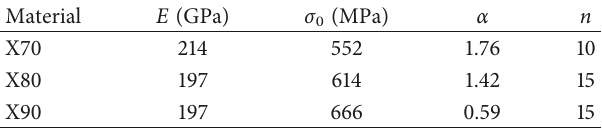
100, a / t 0.2, and θ / π 0.04: (a) X70; (cid:31) (cid:31) (cid:31)